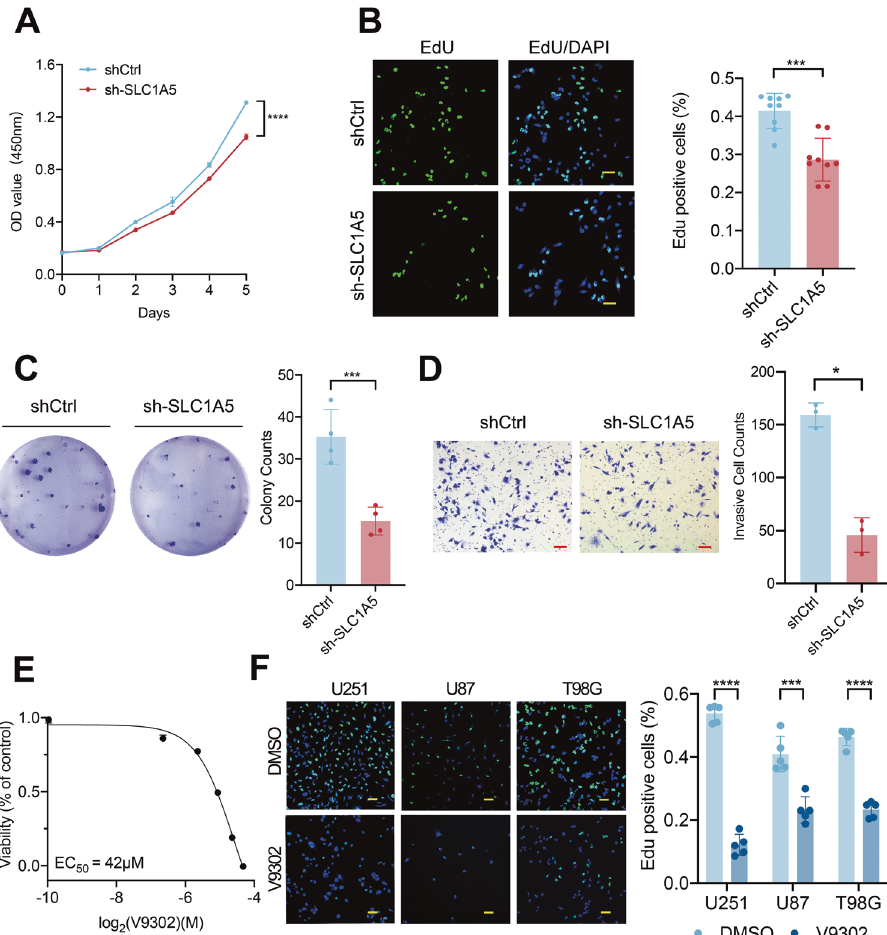
Fig. 3 SLC1A5 regulated the proliferation and invasion of glioma cells in vitro. A The CCK-8 assay results of cell viability after SLC1A5 knockdown. B The EdU assay results of proliferative phase cells after SLC1A5 knockdown (Scale Bar = 20 μ m). C The colony formation results of T98G cells after SLC1A5 knockdown. D The transwell assay results of invasive cells after SLC1A5 knockdown (Scale Bar = 20 μ m). E EC50 of V9302 in T98G cells. F The EdU assay results of proliferative phase cells after V9302 treatment in U251, U87 and T98G cells (Scale Bar = 20 μ